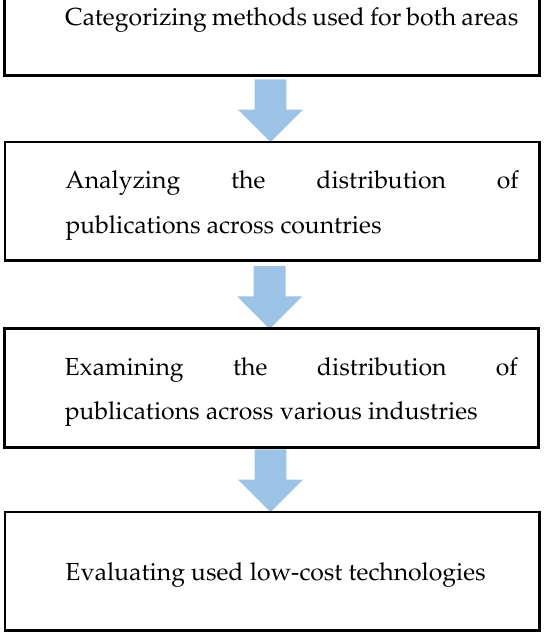
Figure 3. Flowchart depicting the systematic data sampling procedure.